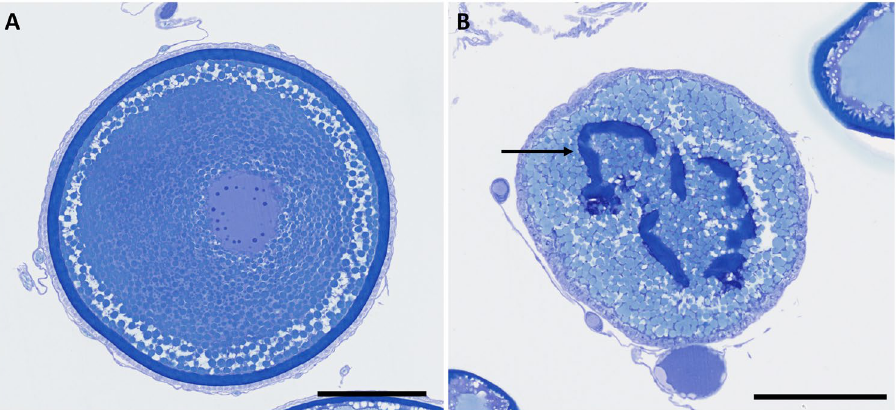
Figure 4. A normal vitellogenic oocyte ( A ) and an atretic oocyte in late alpha residual chorion (LARC) phase ( B ). Arrow indicates chorion remnants. Scale bar = 250 µ m.